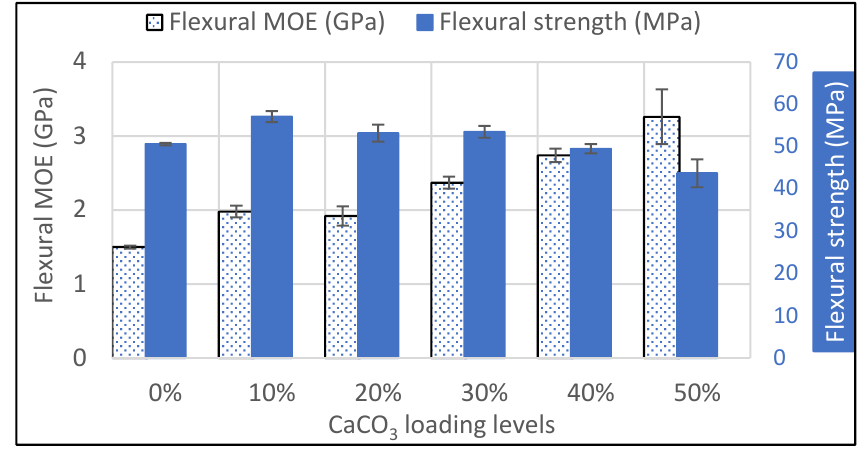
Figure 5. The flexural properties of the HPP and CaCO 3 filled HPP composites.